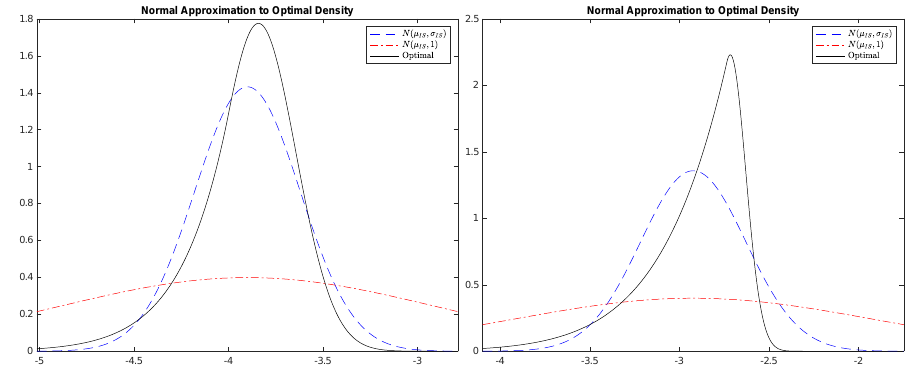
Figure 2. This figure illustrates f x (in fact, the approximation of Equation (40)) for two randomly generated sets of parameters. Each panel superimposes (i) a normal density with the same mean and variance as f x (dashed blue line), and (ii) a normal density with the same mean as f x and unit variance (dash-dot red line). The mean and variance of f x are computed via (computationally inefficient) quadrature. The mean and variance of f x are computed using quadrature. Parameters in the right panel are ( P , ρ D , ρ L , ρ I , ρ S , a , b , N ) = (0.02, 0.33, 0.27, 0.96, 1, 2.47, 4.32, 454), and for the left panel they are ( P , ρ D , ρ L , ρ I , ρ S , a , b , N ) = (0.03, 0.13, 0.12, 0.85, 1, 1.81, 1.90, 271). In both cases, the transformation ( Φ ( x )) h is taken to be h ( x ) = B − 1 a , b